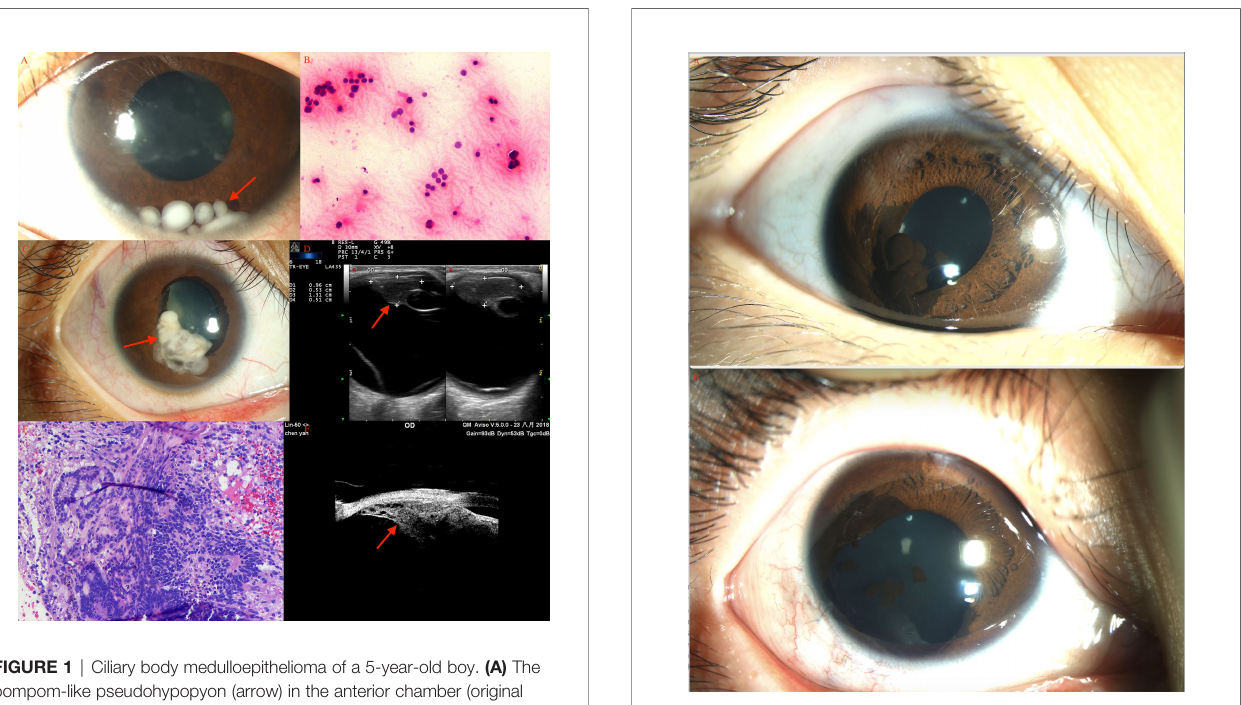
2 patients), RPE hamartoma (1 patient), MALT-lymphoma